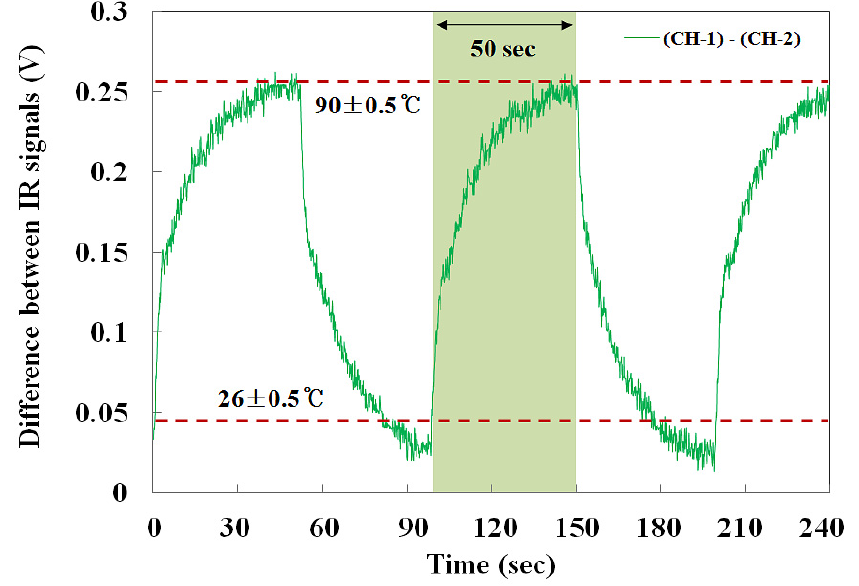
Figure 9. Response time and reproducibility of the embedded IR fiber-optic